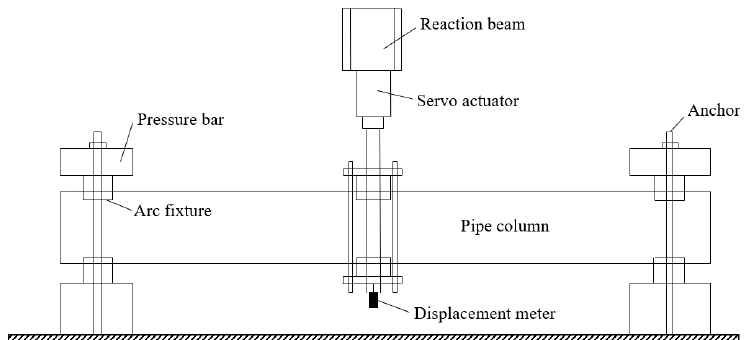
Figure 2. The schematic diagram of the loading device.